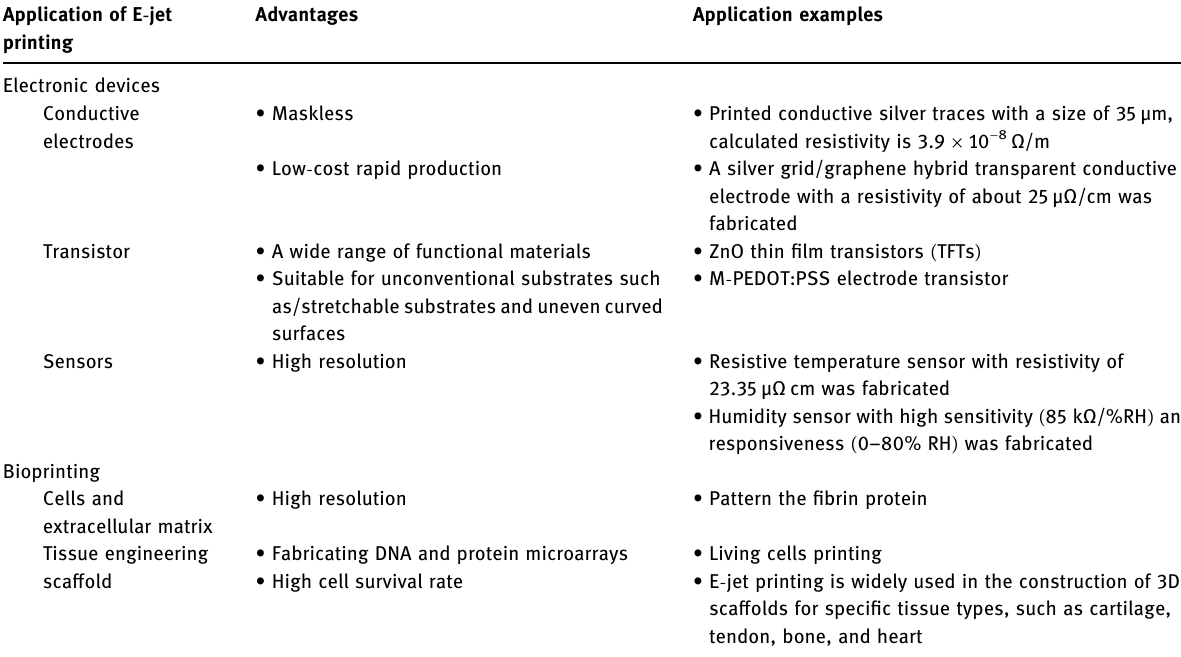
Table 2: Application of E - jet printing Application of E - jet